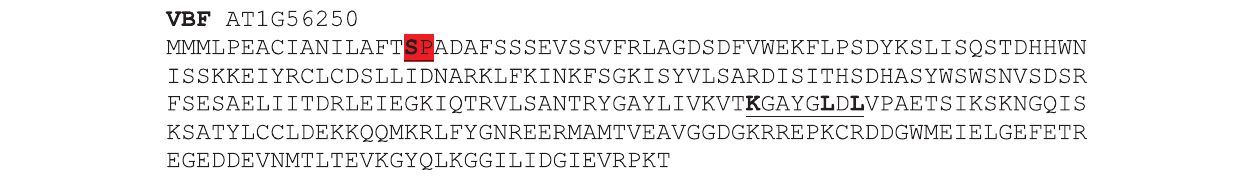
FIGURE 1 | Arabidopsis VBF protein sequence. A peptide matching the consensus motif for MAPK interaction [R/K-x2-6-I/Lx(/L)], and a putative MAPK phosphorylation site are highlighted.